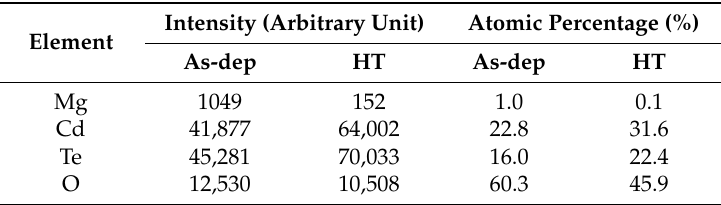
Table 1. Peak intensity and atomic percentages (%) of corresponding elements of CdTe:Mg as-deposited and heat-treated (HT) layers. Intensity (Arbitrary Unit) Atomic Percentage (%) Element As-dep HT As-dep